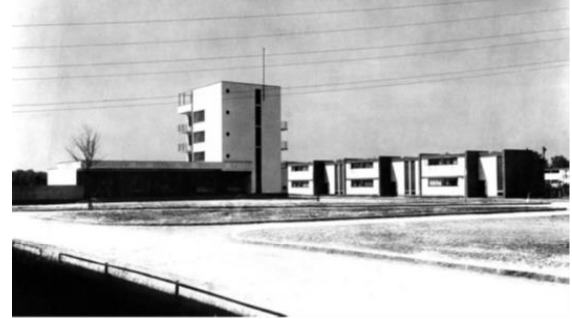
Figure 9. Walter Gropius and the Bauhaus, mass- produced houses at Siedlung Törten-Dessau.